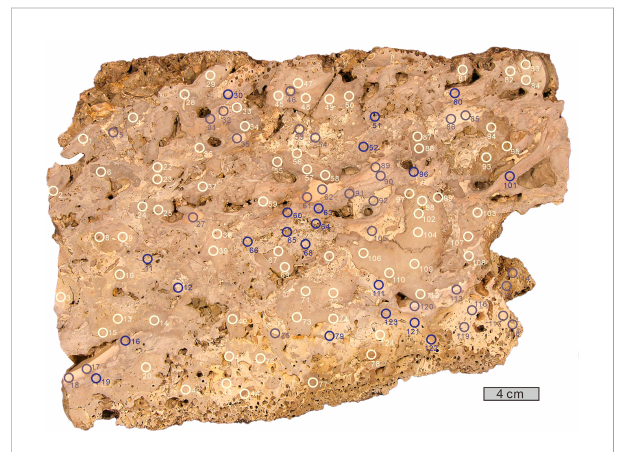
FIGURE 2 Morphology and sampling points for the carbon and oxygen isotopes of seep carbonate. Yellow dots represent clasts, blue dots represent matrix, and purple dots represent pore- fi lling cements. Sponge borings around the perimeter indicate exposure on the sea fl oor (Roberts and Aharon,